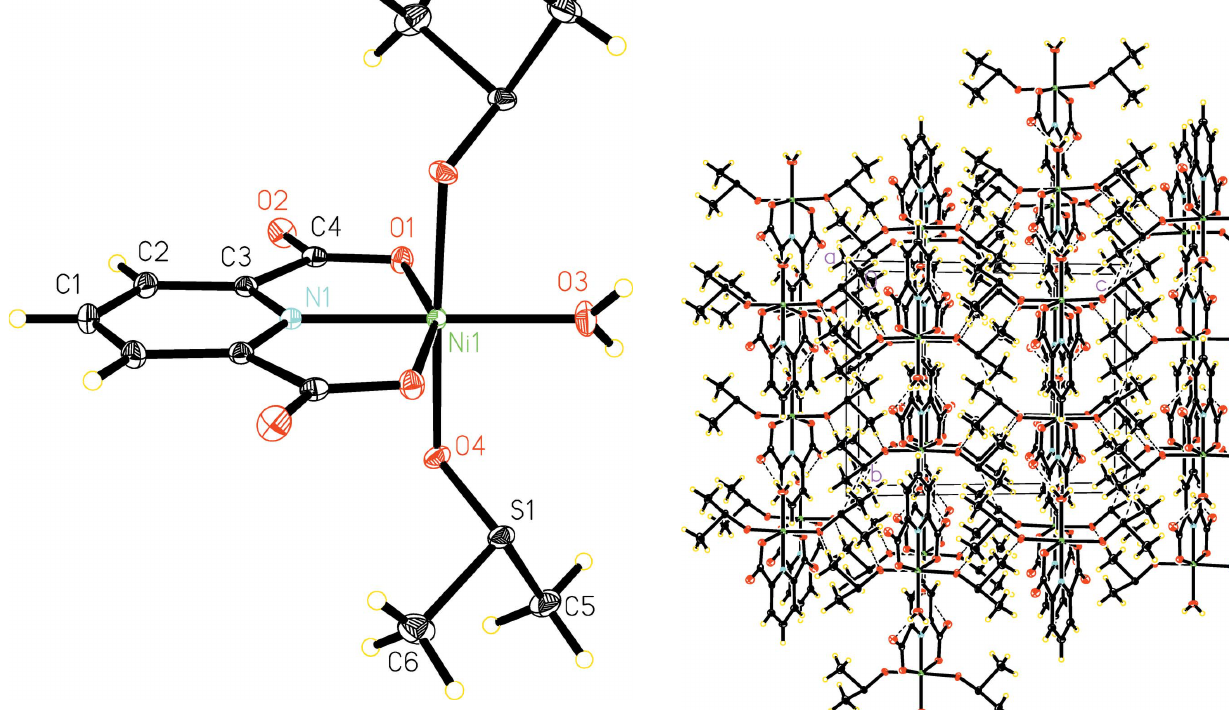
Figure 1 The molecular structure of the title compound, with displacement ellipsoids drawn at the 50% probability level. Unlabeled atoms are related by the symmetry transformation (cid:2) x , y , 1